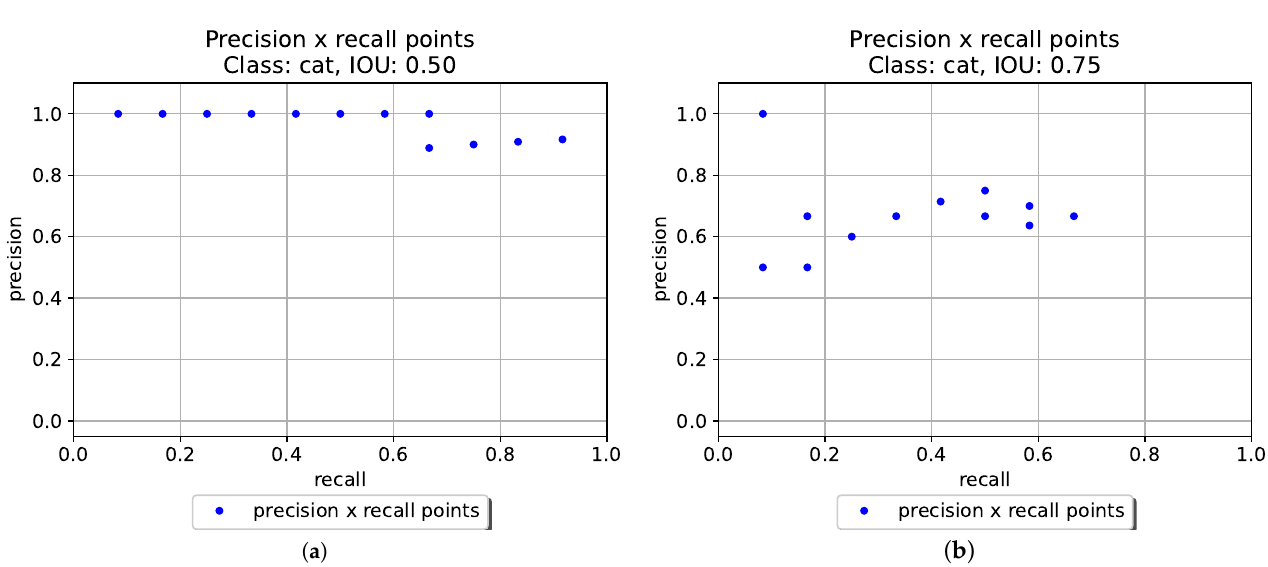
Figure 5. Precision × Recall points with values calculated for: ( a ) Results provided in Table 3. ( b ) Results provided in Table